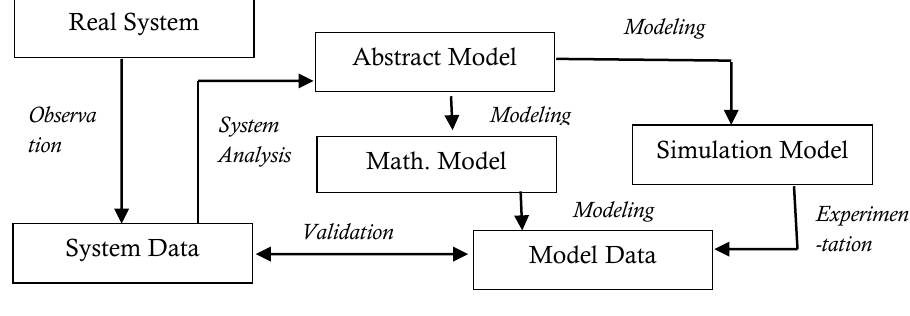
Figure 1. The scientific identification theory (Hardhienata,